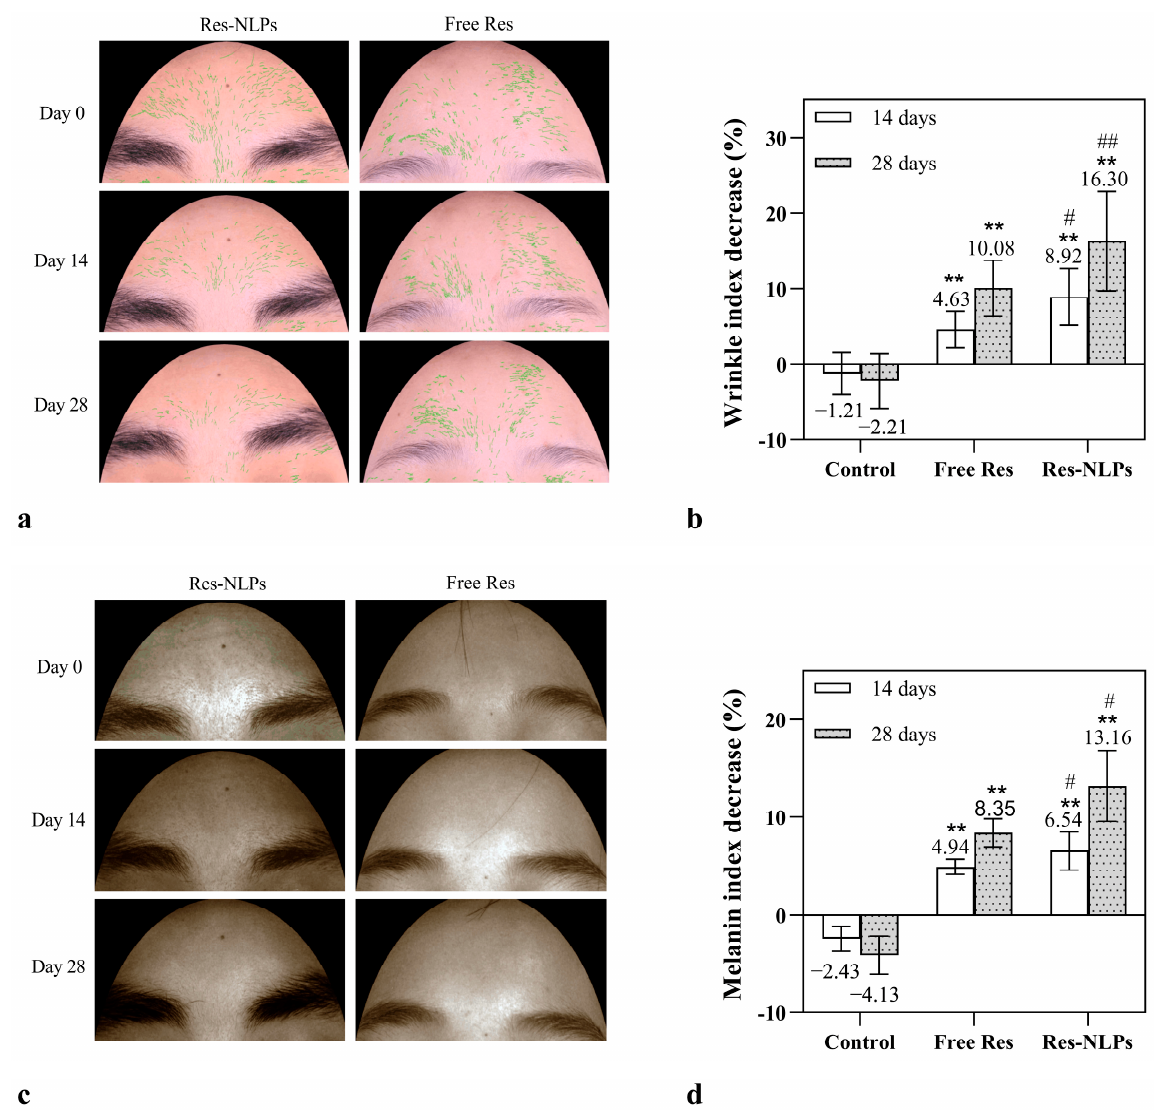
Figure 9. The anti-aging and skin-brightening effects of Res studied on human skin. ( a ) Representative photographs of wrinkle imaging of Chang’e skin detector on the forehead area of volunteers before and after 2 and 4 weeks of treatment with the free Res or Res-NLPs with the same Res concentration as the free Res. ( b ) The decrease (%) in wrinkle index of volunteers after 2 and 4 weeks of treatment with the Res-NLPs or free Res. ( c ) Representative pictures of melanin imaging of Chang’e skin detector in the forehead area of volunteers after 2 and 4 weeks of using the Res-NLPs or free Res. ( d ) The decrease (%) in melanin index of after 2 and 4 weeks of using the Res-NLPs or free Res. Mean ± SD ( n = 11). ** p < 0.01, compared with the control group; # p < 0.05, ## p < 0.01, compared with the free Res group.